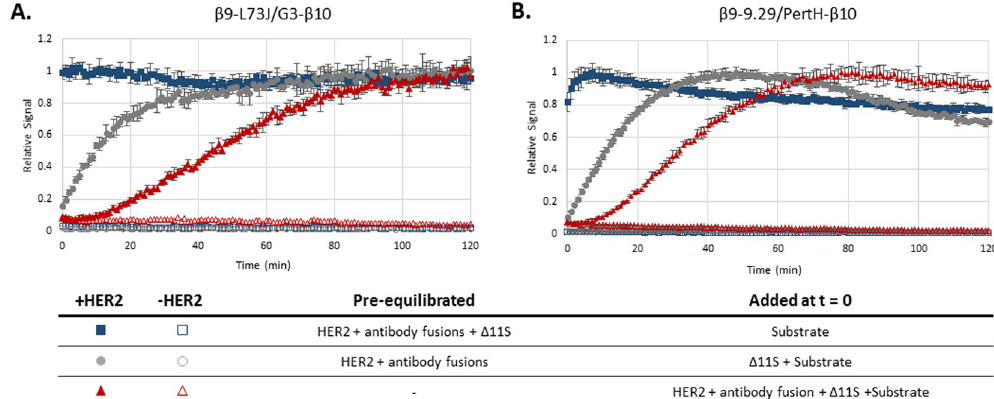
Figure 5. Signal Kinetics of TEC. ( A ) The signal kinetics with the combination of β 9-L73J (12.5 nM)/G3- β 10 (2.5 nM) or ( B ) β 9-9.29 (2 nM)/PertH- β 10 (20 nM). The kinetics of the single-step TEC assays are compared to two different conditions pre-equilibrated with HER2: antibody fusions (gray circles), or antibody fusions and Δ 11S (blue squares). The difference between the pre-equilibrated solutions indicate the kinetics of binding between antibodies and HER2 and between the peptides and Δ 11S. Δ 11S lysate was diluted 1:20 and Nano-Glo substrate was 10 μ M in all